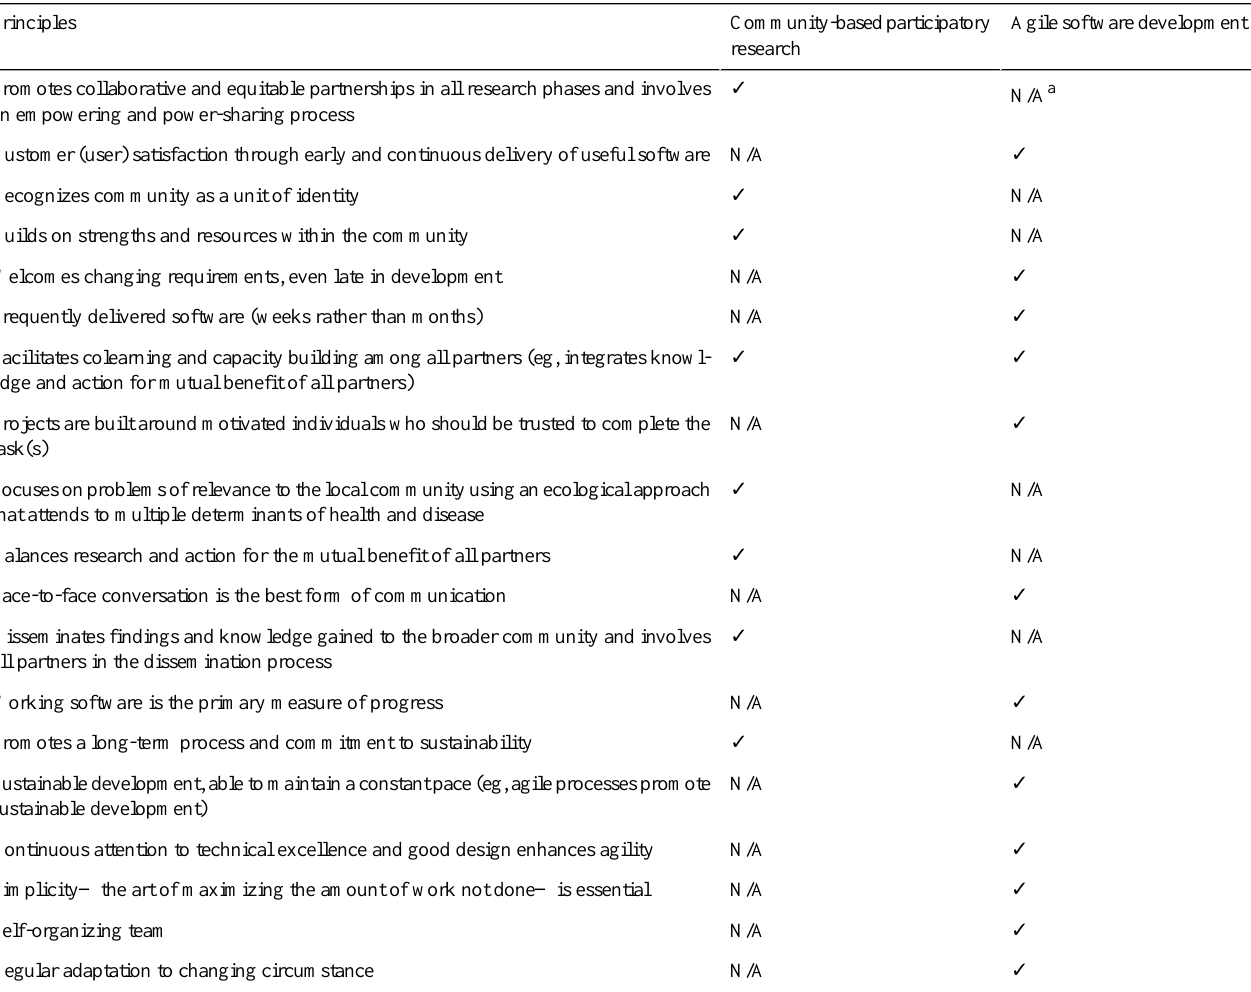
Table 1. Key and complementary principles of agile software development and community-based participatory research.